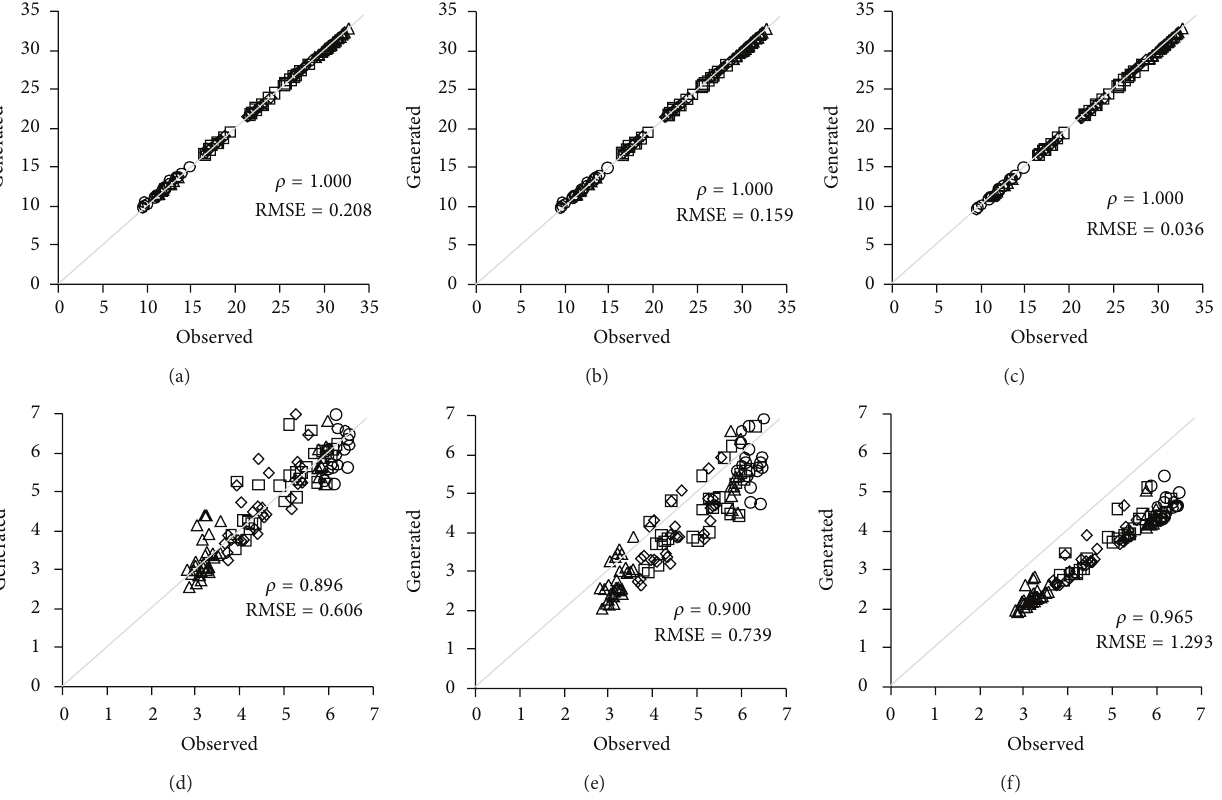
Figure 7: Comparison between observed versus generated ((a), (b), (c)) mean maximum temperatures ( ∘ C) and ((d), (e), (f)) standard deviations of maximum temperatures ( ∘ C) for each month. ((a), (d)) first model, ((b), (e)) second model, and ((c), (f)) third model. ( I